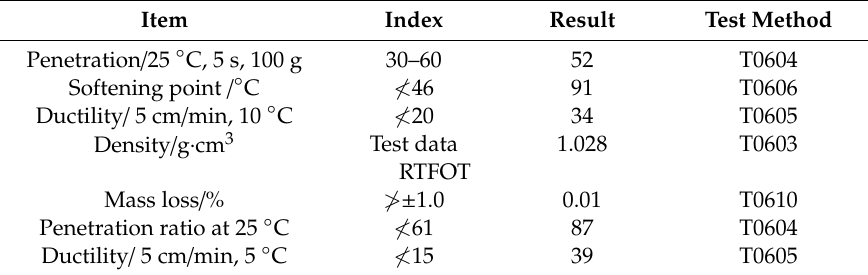
Table 2. Physical properties of modified asphalt with penetration grade of 30 / 60 pen.